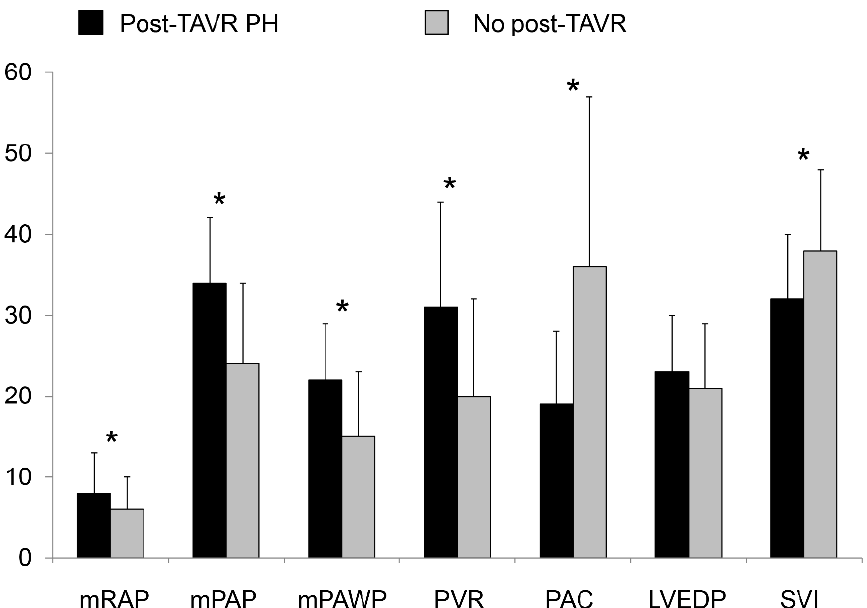
Figure 1. Hemodynamics prior to aortic valve replacement in patients with and without pulmonary hypertension several months after aortic valve replacement (post-AVR PH, defined as systolic pul- monary artery pressure > 45 mmHg by echocardiography). Bar graphs represent means ± standard deviations. * p < 0.01 . LVEDP = left ventricular end-diastolic pressure; mPAP = mean pulmonary artery pressure; mPAWP = mean pulmonary artery wedge pressure; mRAP = mean right atrial pres- sure; PAC = pulmonary artery capacitance; PVR = pulmonary vascular resistance; SVI = stroke vol- ume index. The scale is mmHg, Wood units × 10, mL/mmHg × 10, and mL/m 2.